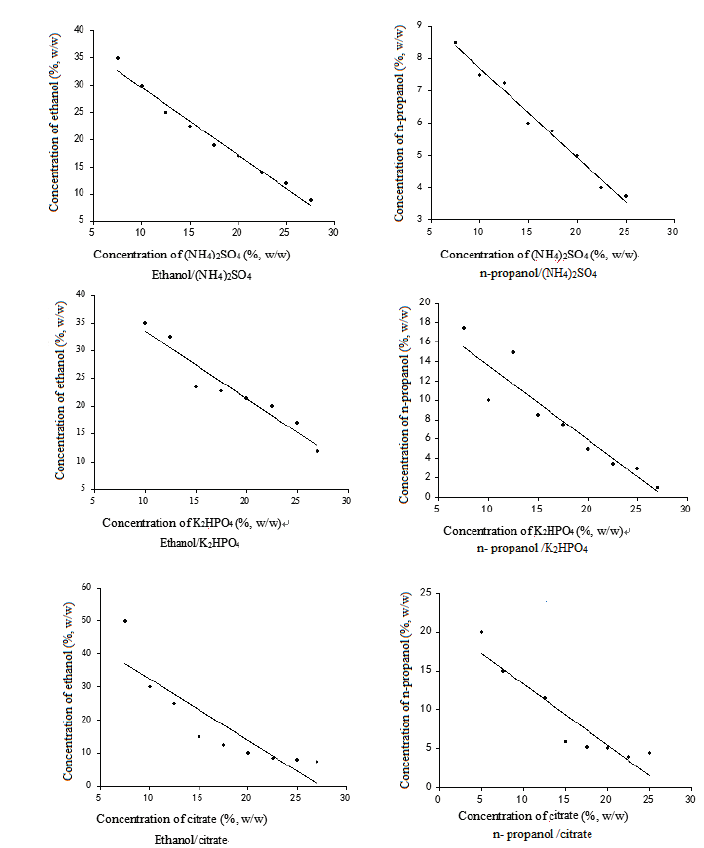
Figure 2. Phase diagram of different aqueous two-phase